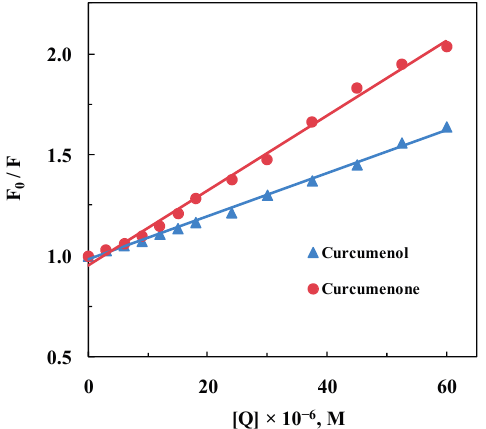
Figure 3. Stern-Volmer plots for the quenching of HSA fluorescence by curcumenol and